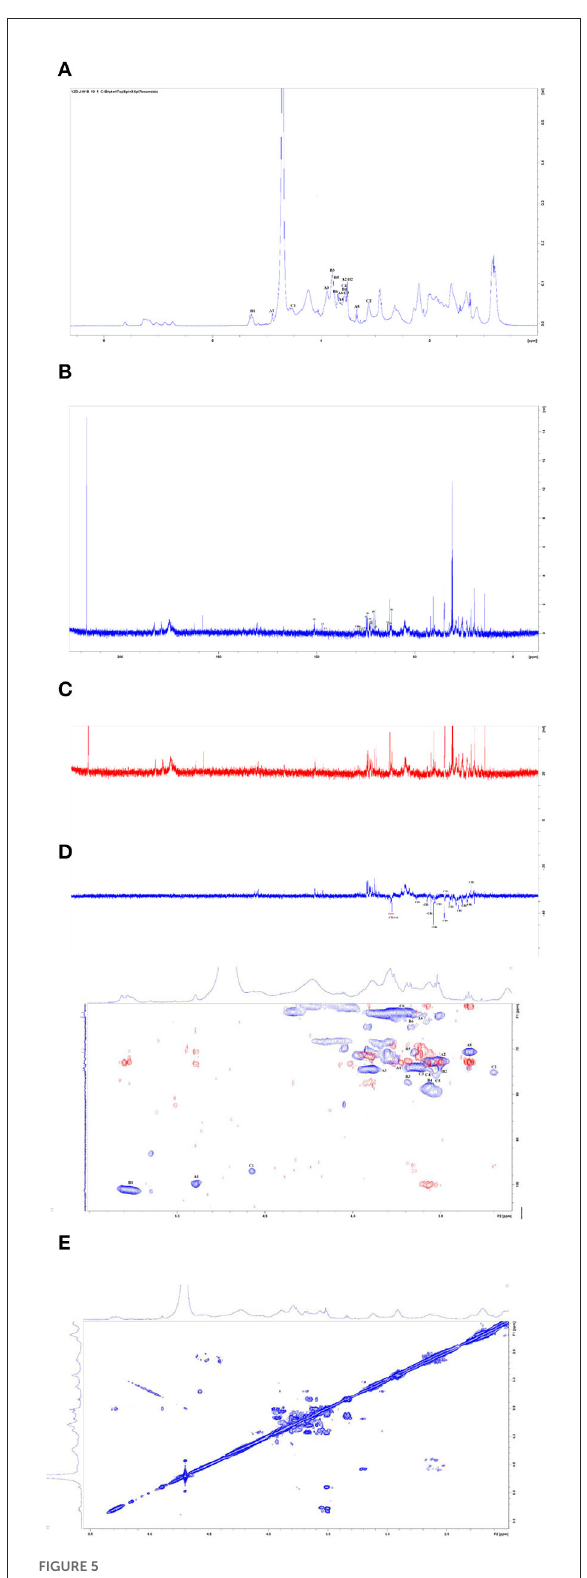
FIGURE5 Nuclear magnetic resonance (NMR) spectra of CAG-1 in D 2 O. (A) 1 H spectra; (B) 13 C spectra; (C) DEPT 135 ; (D) HSQC (in blue) + HMBC spectra (in red); and (E) COSY spectra.